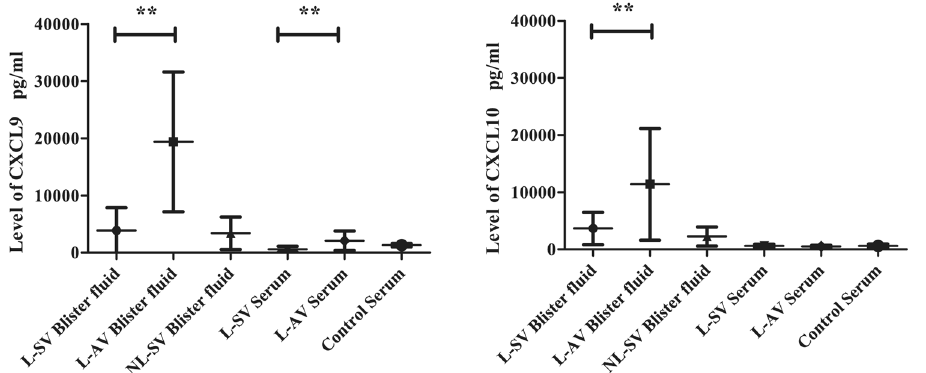
Figure 2. The mean levels of CXCL9 and CXCL10 in different groups. *P < 0.05, **P <